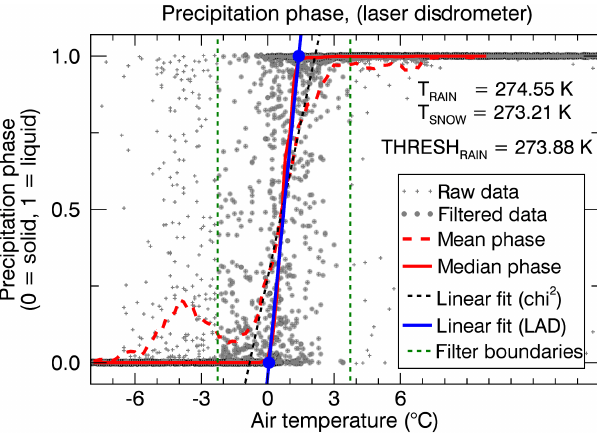
Figure A2. From the precipitation phase measured by the disdrom- eter we determined a mean rain/snow threshold of 0.73 ◦ C using a robust least-absolute-deviation (LAD) fit (blue line). A linear fit provides the same threshold but a slightly lower slope. Before fit- ting, we set a filter boundary (green dotted line) of 0 . 73 ± 3 ◦ C. Data outside the boundary are considered to be misclassified precipita-